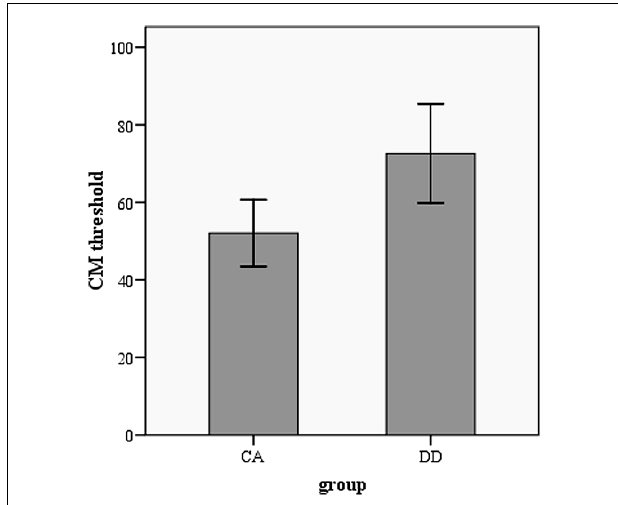
FIGURE 1 | CM threshold in dyslexia group and age-matched control group.